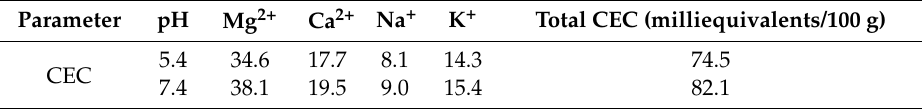
Table 3. Cation exchange capacity of activated clay in milliequivalents/100 g with exchangeable chemical species.